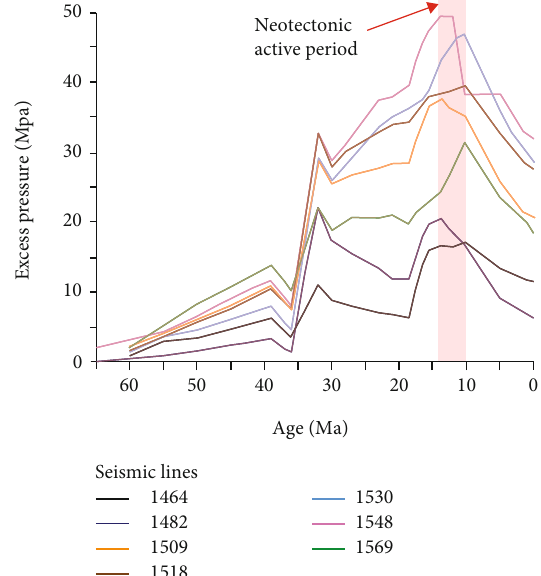
Figure 6: Formation pressure evolution in Baiyun Sag (modify from